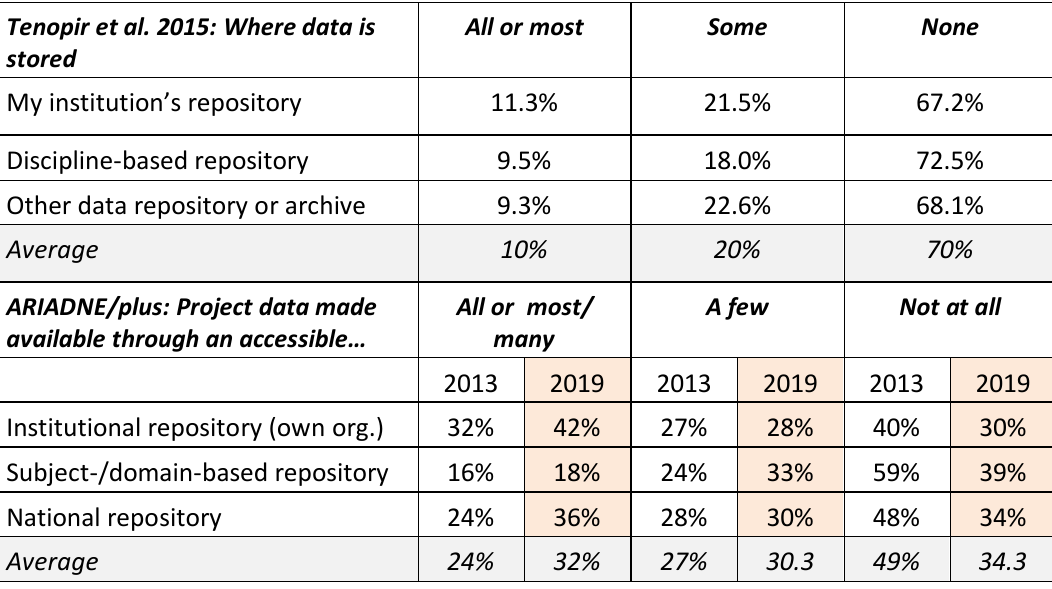
Table 9 : Comparison of the use of repositories. Tenopir et al. 2015, N = max. 1000; ARIADNE 2013, N = 516-521; ARIADNEplus 2019, N = 437-457.